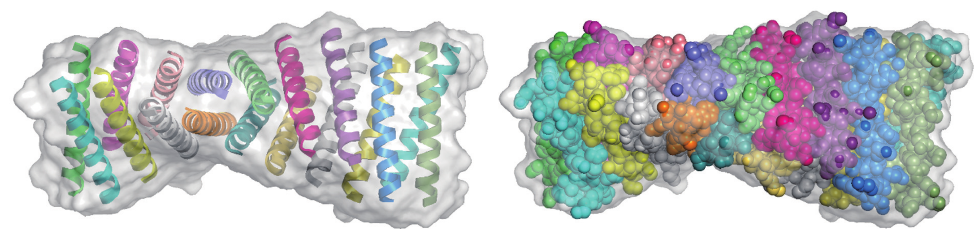
Figure 2. The structure of a coiled-coil protein with PDB code 6c4y, consisting of 18 copies of a short helix [24]. AlphaFold predicts an accurate model of each helix, but it is difficult to obtain the model of the whole molecule with MR. The molecule is shown as cartoon on the left and as sphere on the right. The true protein envelope computed from the PDB atomic model is shown as gray